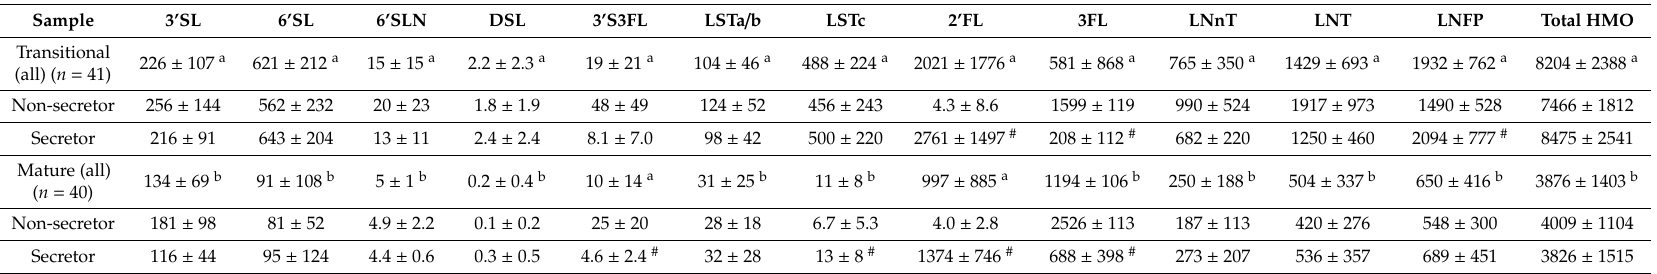
Table 1. Human milk oligosaccharide (HMO) concentration in transitional and mature human milk from United Arab Emirates (UAE) mothers. 3’SL, 3’-sialyllactose; 6’SL, 6’-sialyllactose; 6’SLN, 6’-sialyllactosamine; DSL, disialyllactose; 3’S3FL, 3’-sialyl-3-fucosyllactose; LSTa / b, LS-tetrasaccharide a / b; LSTc, LS-tetrasaccharide; LNnT, lacto-N-neotetraose; LNT, lacto-N-tetraose LNFP, lacto-N-fucopentaose I; 2’FL, 2’-fucosyllactose; 3FL, 3-fucosyllactose.